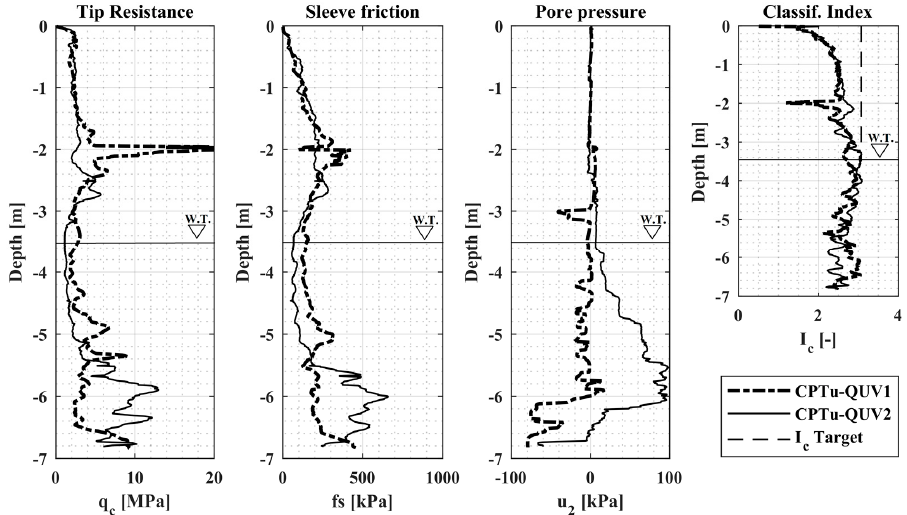
Figure 8. CPTu test results at QUV site.